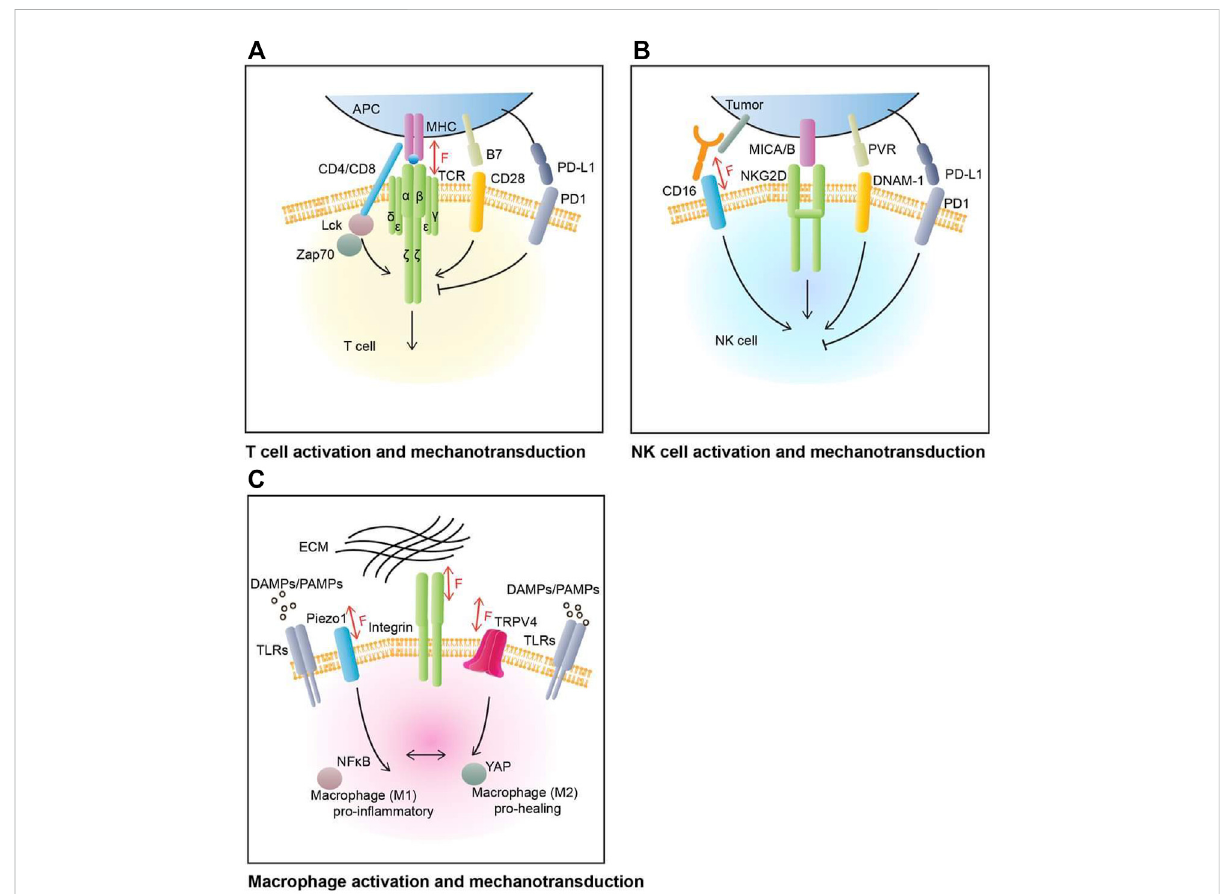
FIGURE 1 T cell, NK cell, and macrophage activation and mechanotransduction. (A) T cell ’ s main activation and inhibition molecular pathways. The main activation receptorforTcell isTCR, whichbinds toMHC complexinantigen presentingcells (APCs). CD28 isoneofTcell ’ sco-stimulatoryreceptor, with its ligand B7. PD1 is one of T cell ’ s co-inhibitory receptors, with its ligand PD-L1. TCR can sense, mediate, and generate mechanical force through TCR-pMHC complexes. (B) NK cell ’ smajor activation and co-stimulation molecular pathways. The activation of NK cell is mediated by the balance of activating and inhibitory receptors network. NK cell main activation molecules include NKG2D (natural killer group 2D) and DNAM-1 (DNAX accessory molecule 1) and some of their ligands PVR and MICA/B (MHC class I polypeptide-related sequence A/B). PD1 is an example of NK cell inhibitory receptor, with its ligand PD-L1 on tumor cells. The CD16 Fc receptors can recognize cell-bound antibodies and trigger tumor cell apoptosis. CD16 can be involved in NK cell mechanosensing. (C) Macrophage ’ s polarization and mechanotransduction. Macrophage respond to various environment cues to perform its housekeeping role. Pathogen-associated molecular patterns (PAMPs) and damage-associated molecular patterns (DAMPs) are major family of signals that induce macrophage ’ s activation through Toll-like receptors (TLRs). Mechanosensitive ion channels and adhesion proteins on macrophage ’ s plasma membrane help transducing mechanical input such as topological patterns or stiffness of extracellular matrix (ECM). These inputs will regulate the polarization of macrophage between pro-in fl ammatory (M1) and pro-healing (M2) phenotypes as well as enhancing phagocytic function of